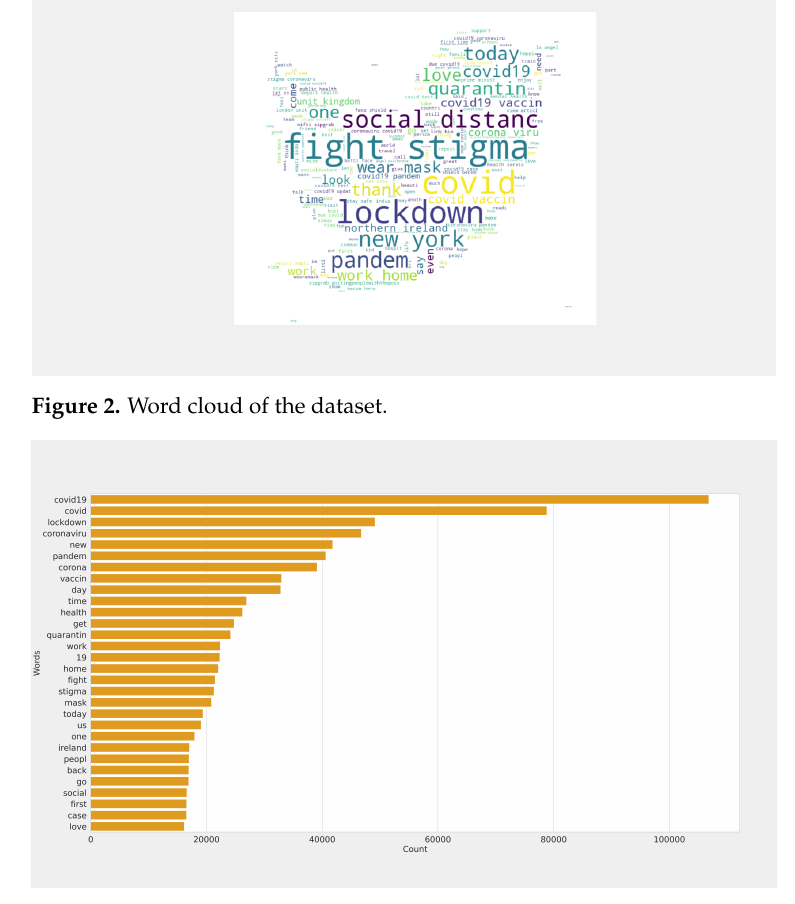
Figure 3. The most frequent word